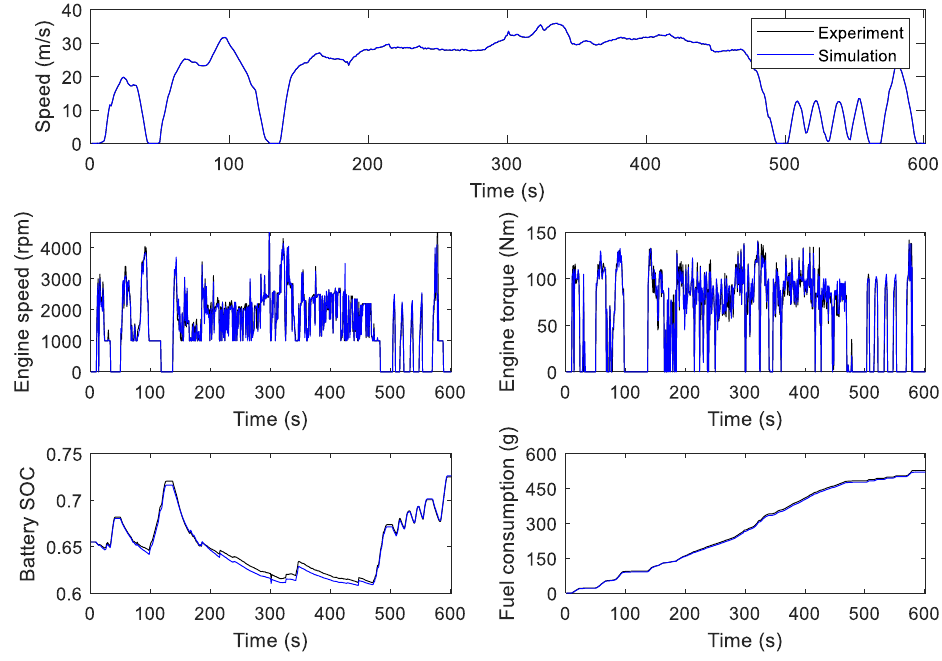
Figure 6. Heuristic strategy comparison between experiment and simulation.